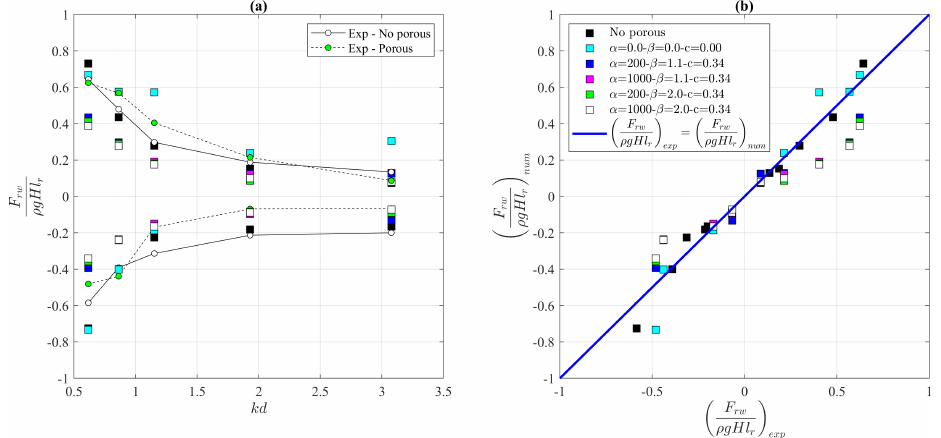
Figure 12. Comparison between the wave loading at the rear wall estimated from the experimental data and that estimated from the numerical model: ( a ) F rw as a function of kd ; ( b ) F rw , exp vs. F rw , num